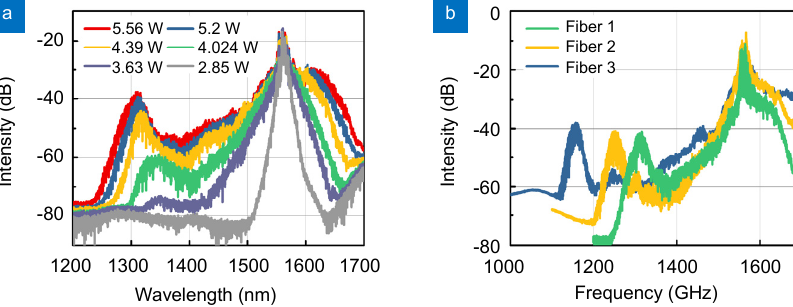
Fig. 7 | ( a ) Optical spectra with a dispersive wave centered around 1310 nm from a fluorotellurite fiber under different launched powers of the femtosecond laser. ( b ) Optical spectra with tunable dispersive waves ranging from 1150 nm to 1310 nm from fluorotellurite fibers 1, 2, 3 with ZDWs at 1358 nm, 1409 nm and 1452 nm,